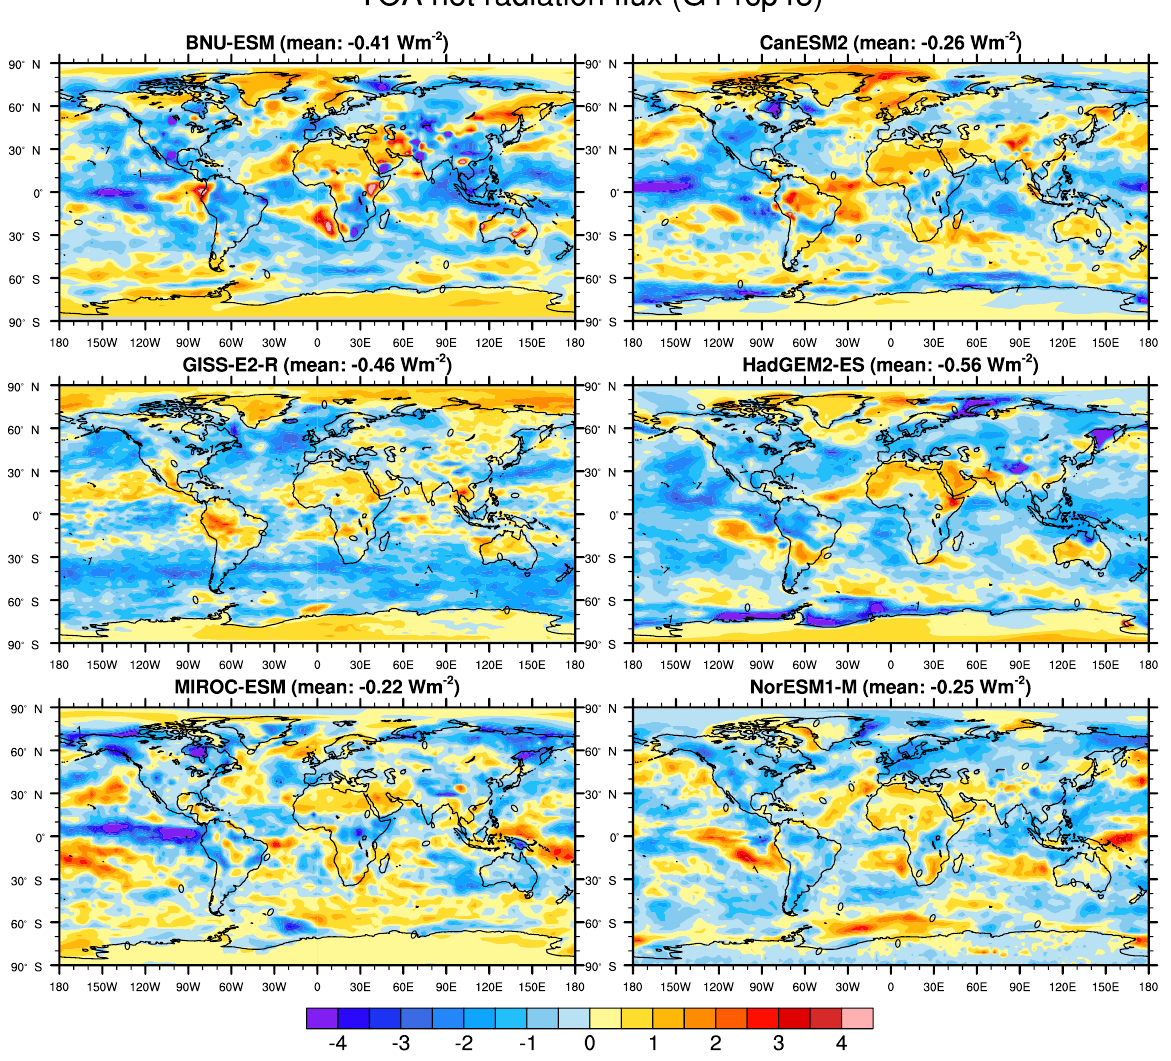
Figure A2. Geographical distributions over the 40-year analysis periods of the differences G4 − rcp45 for TOA net radiation flux for BNU- ESM, CanESM2, GISS-E2-R, HadGEM2-ES, MIROC-ESM and